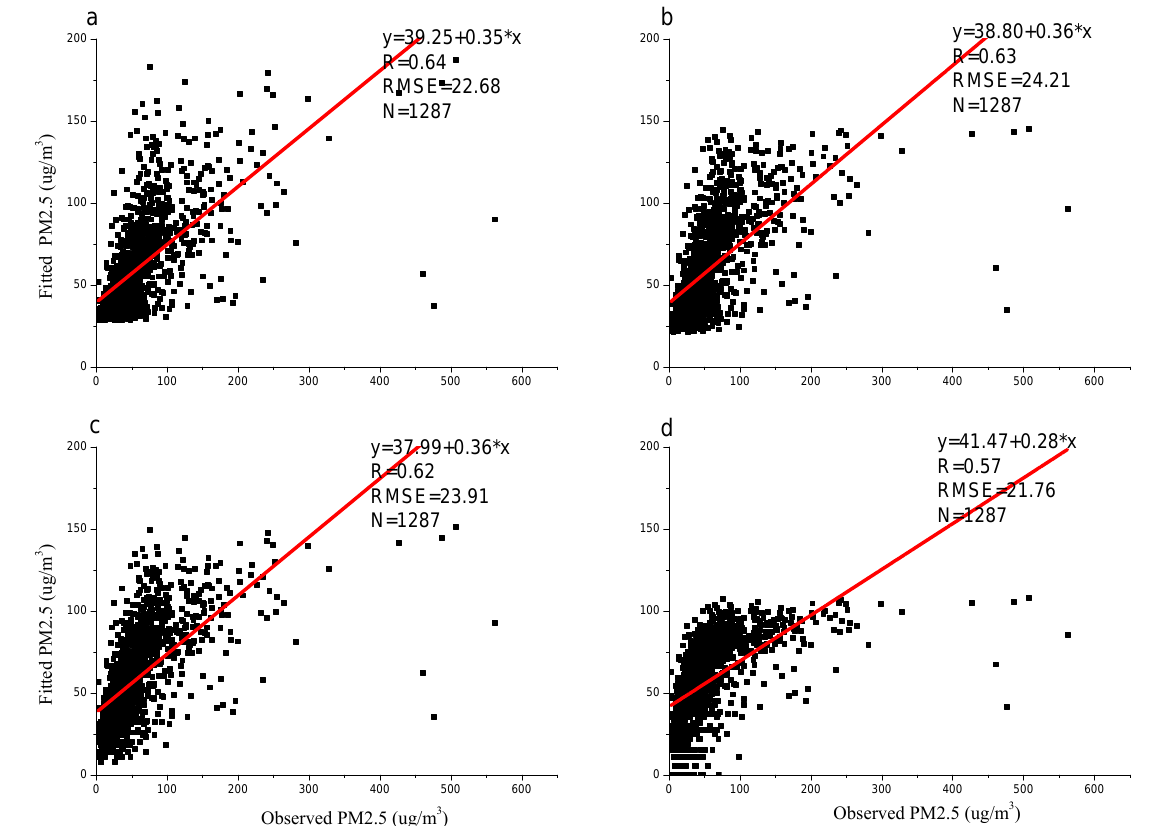
Figure 4. The validation of the four models ( p < 0.05) ( a ) the linear regression model; ( b ) the quadratic regression model; ( c ) the power regression model, and ( d ) the logarithmic regression model.